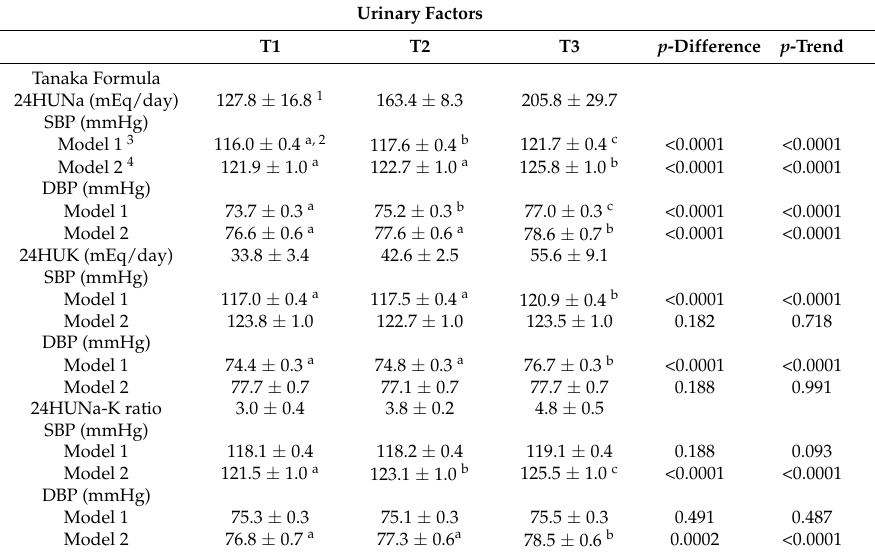
Table 3. Associations between blood pressure and 24 h estimated urinary factors obtained with Tanaka and Kawasaki formulas in sample